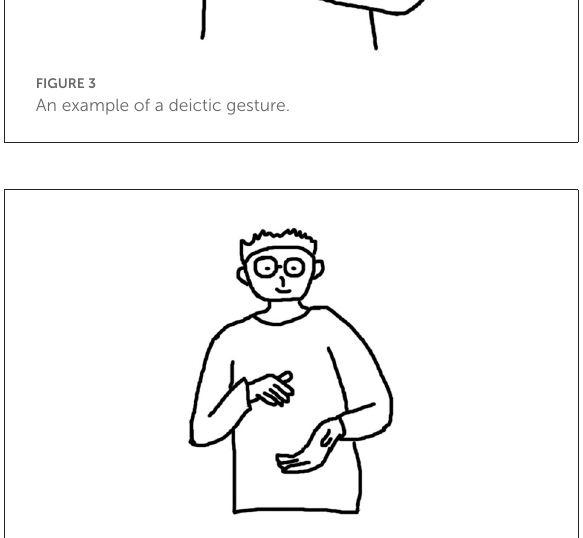
FIGURE4 An example of a beat